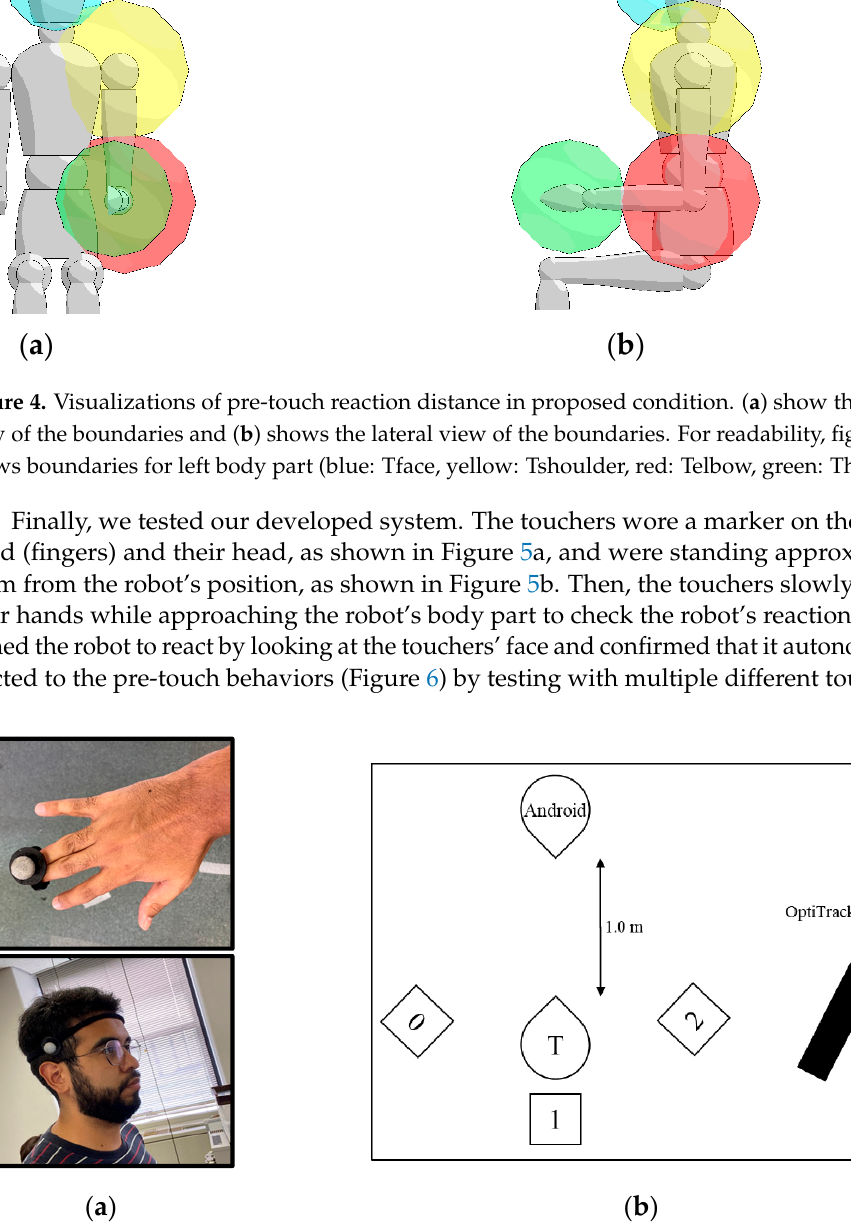
Figure 6. Reaction to potential touch to elbow implementing obtained model: ( a ) method used for detecting when the android should react considering the distance between the participant’s hand and the android’s elbow; ( b ) android pre-touch reaction.